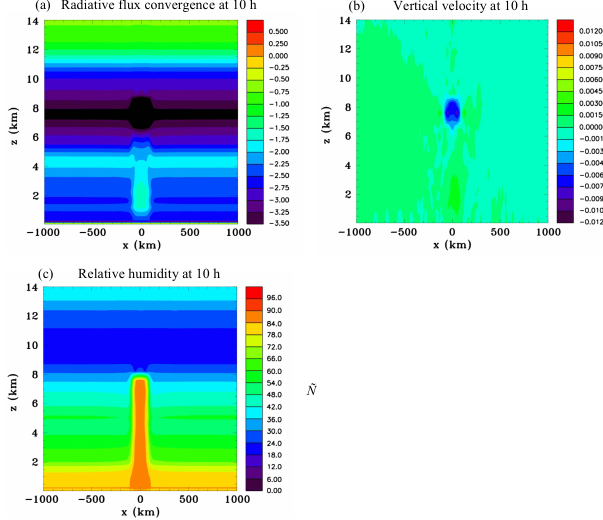
Figure 15. Vertical sections for Experiment 11: the radiation scheme activated in the whole domain with a mid-level vortex case. (a) Radiative flux convergence (Ks − 1 × 10 − 5 ), (b) vertical velocity (ms − 1 ), (c) relative humidity, at t = 10h, during the